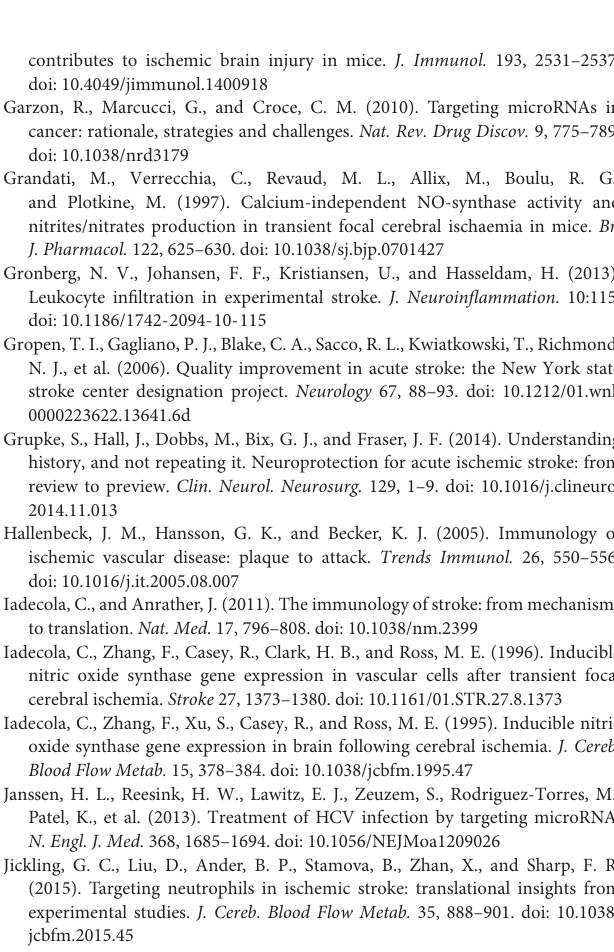
FIGURE S1 | MiR-122 mimic (2.4 mg/kg, i.v., given at 6 h after MCAO) reduces brain infarction 24 h after MCAO in rats. Scrambled miRNA or miR-122 mimic was wrapped using PEG-liposomes prior to administration (i.v.) after MCAO. A : Cresyl Violet staining; B : infarction volume. ∗ p < 0.05, ∗∗ p < 0.01 vs. MCAO/scramble miRNA. n = 6/group. TABLE S1 | MiR-122 mimic does not significantly affect body temperature (BT) and blood oxygen saturation (BOS) after MCAO in rats. Statistical differences between the groups were determined using repeated measures ANOVA followed by Dunnett’s post hoc